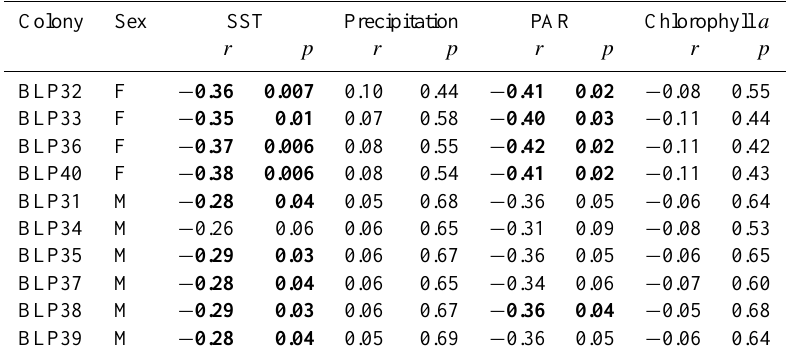
Table 2. Correlation coefficients between skeletal δ 18 O of Porites panamensis colonies and: sea surface temperature, precipitation, photo- synthetically active radiation and chlorophyll a from Bahía de La Paz. Time period covered by correlations is from 1997 to 2009. Temporal resolution of data is quarterly. Bold numbers indicate significant ( p< 0 . 05)